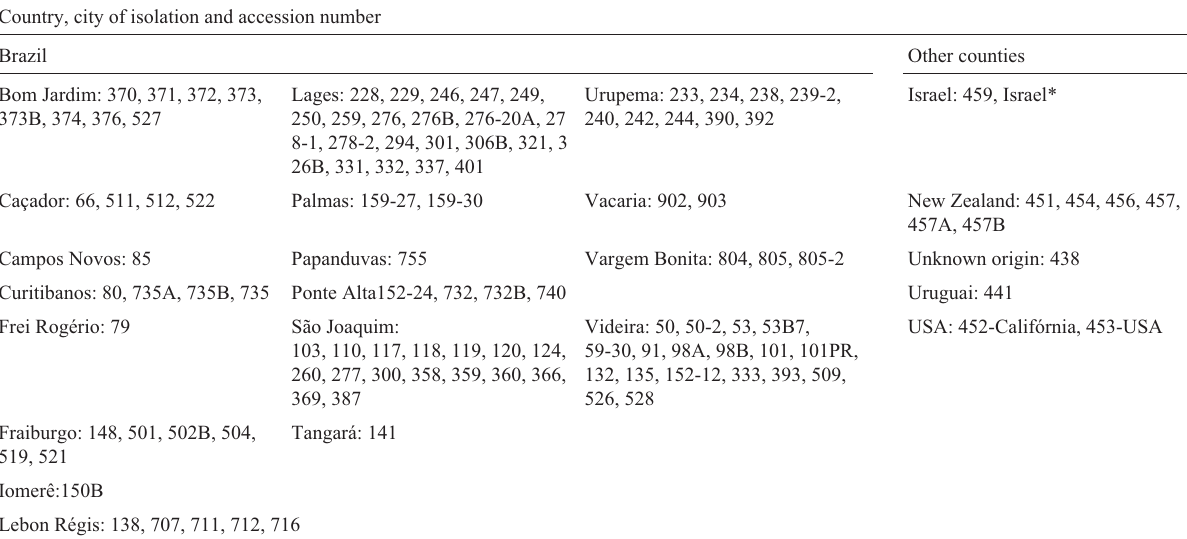
Table 1 - Accession number and origin of the 119 accessions from the Active Germoplasm Bank of Goiabeira-serrana located at the São Joaquim/Epagri Experimental Station in the Brazilian state of Santa Catarina. All the Brazilian cities are located in the state of Santa Catarina. Country, city of isolation and accession number Brazil Other counties Bom Jardim: 370, 371, 372, 373, 373B, 374, 376,